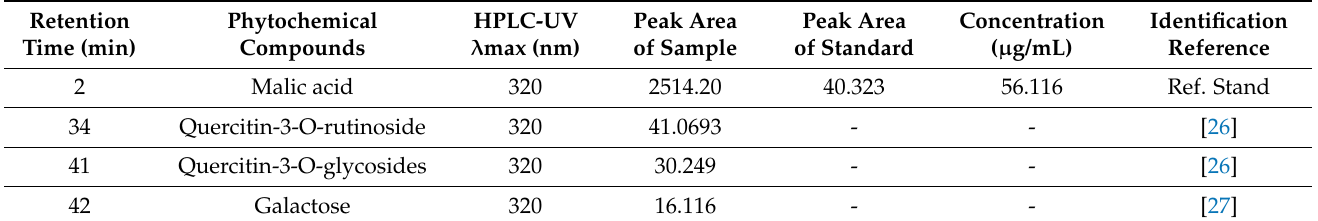
Table 6. Identified phytochemicals in purified fraction D of A. articulata through the HPLC-UV technique.